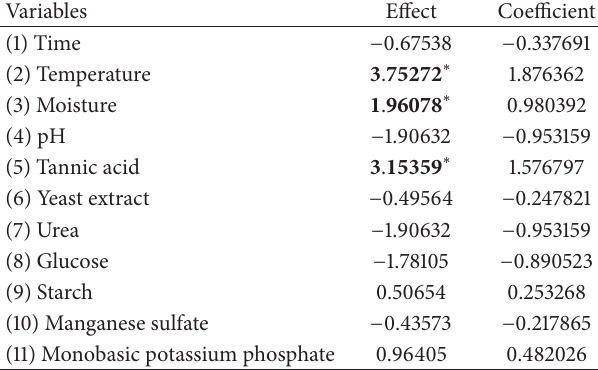
Table 4: Results and coefficient effect for the production of tannase presented by the variables used in the Plackett-Burman design (PB).